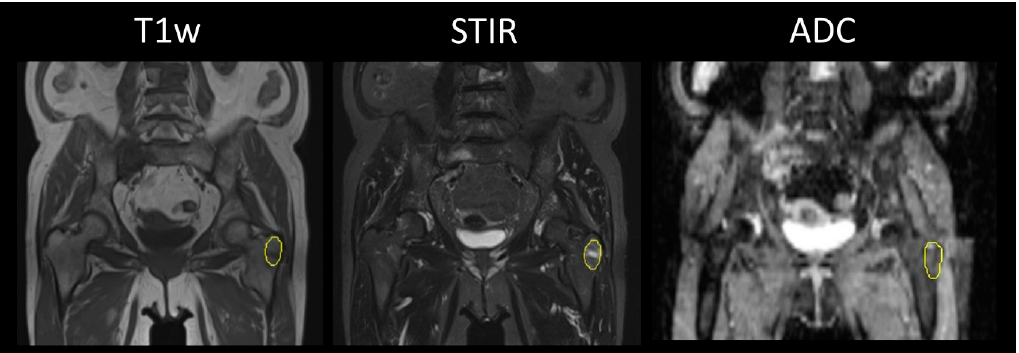
Figure 1. Exemplary case in a 66-year-old female myeloma patient prior to treatment, stage IIIa (according to the Durie & Salmon criteria). The focal myeloma lesion in the left greater trochanter is segmented on T1w and STIR sequence, as well as on apparent diffusion coefficient (ADC)